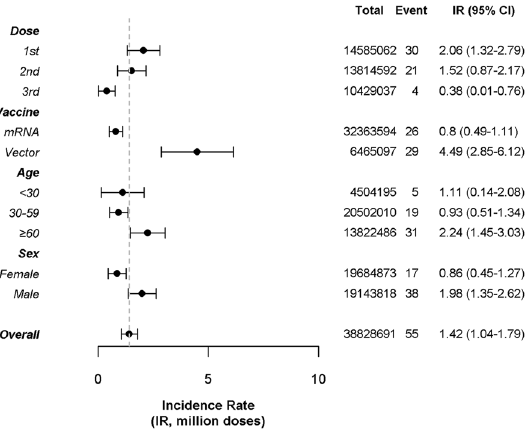
Figure 3. Incidence rate of GBS following SARS-CoV-2 vaccination, stratified by number of doses, vaccine types, age group and sex. Total doses of each vaccines administered, the number of events reported, and the incidence rate (IR) of GBS per dose, vaccine mechanism, age group, and sex are illustrated